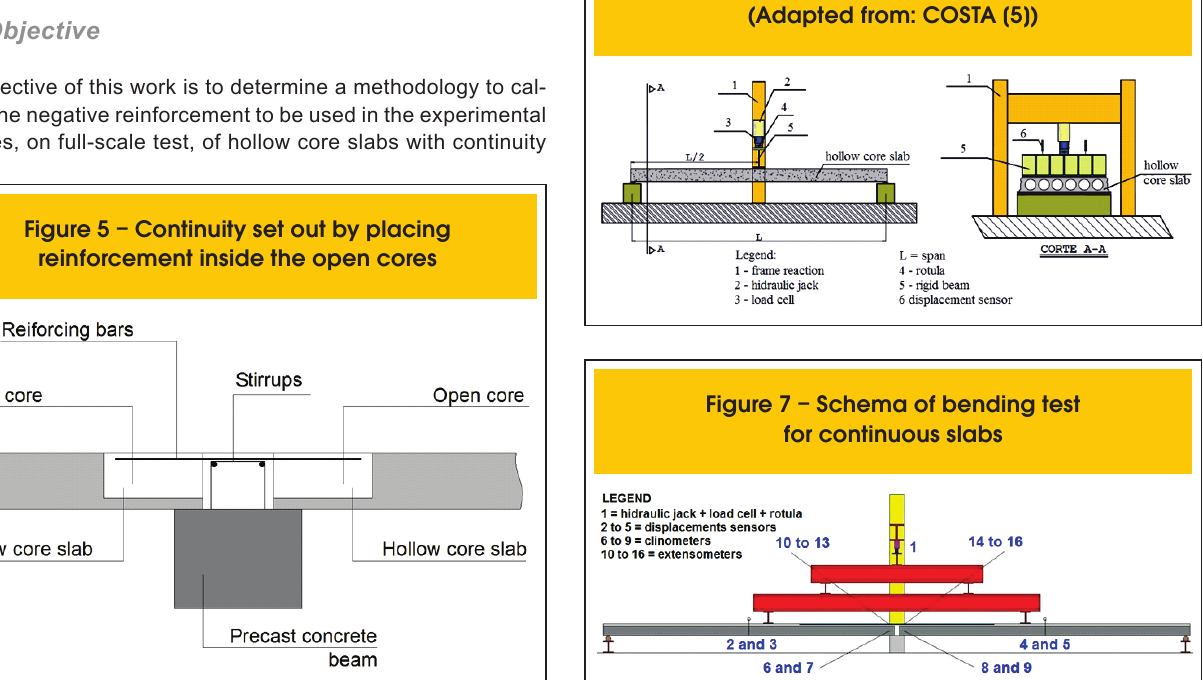
Figure 6 – Schema of bending test for single slabs (Adapted from: COSTA [5])